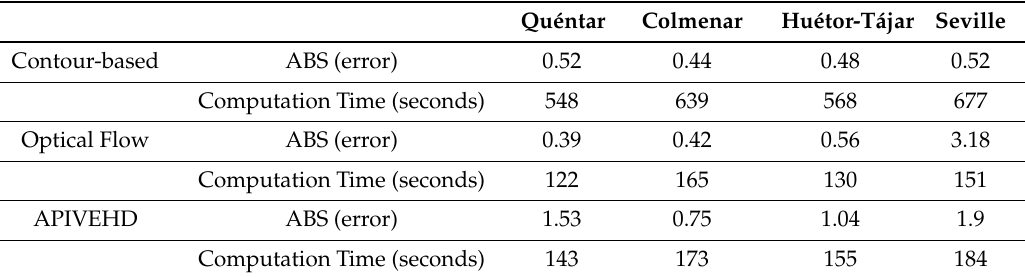
Table 10. Horizontal displacement absolute errors and computation time obtained using contours, optical flow and PIV